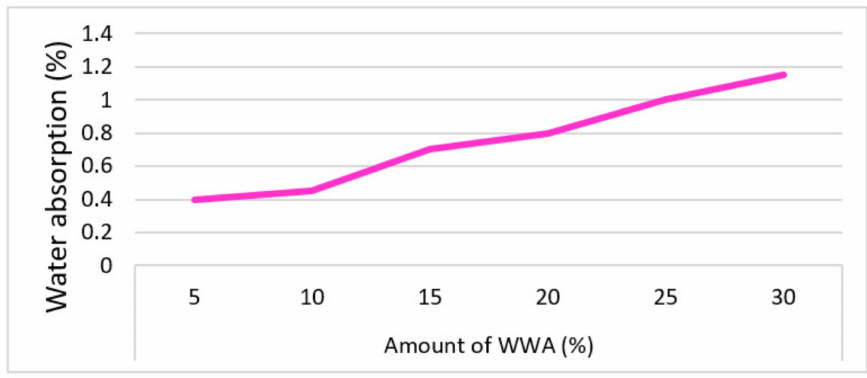
Figure 3. Co-relation of water with WWA in concrete (data from reference